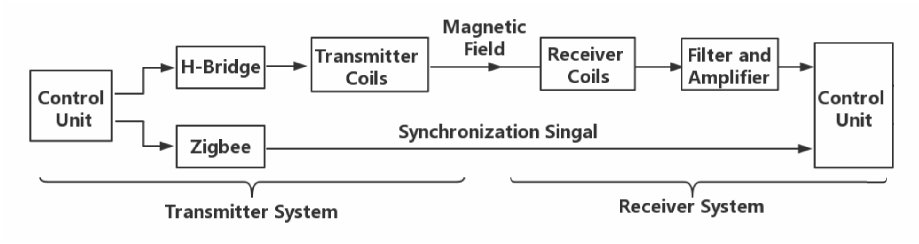
Figure 2. System Architecture.